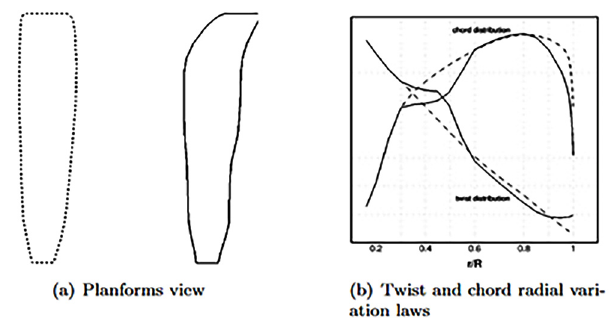
Figure 5. Comparison between reference blade (dashed line), and optimized blade (solid line) [31]. Reprinted with permission from Pagano, A.